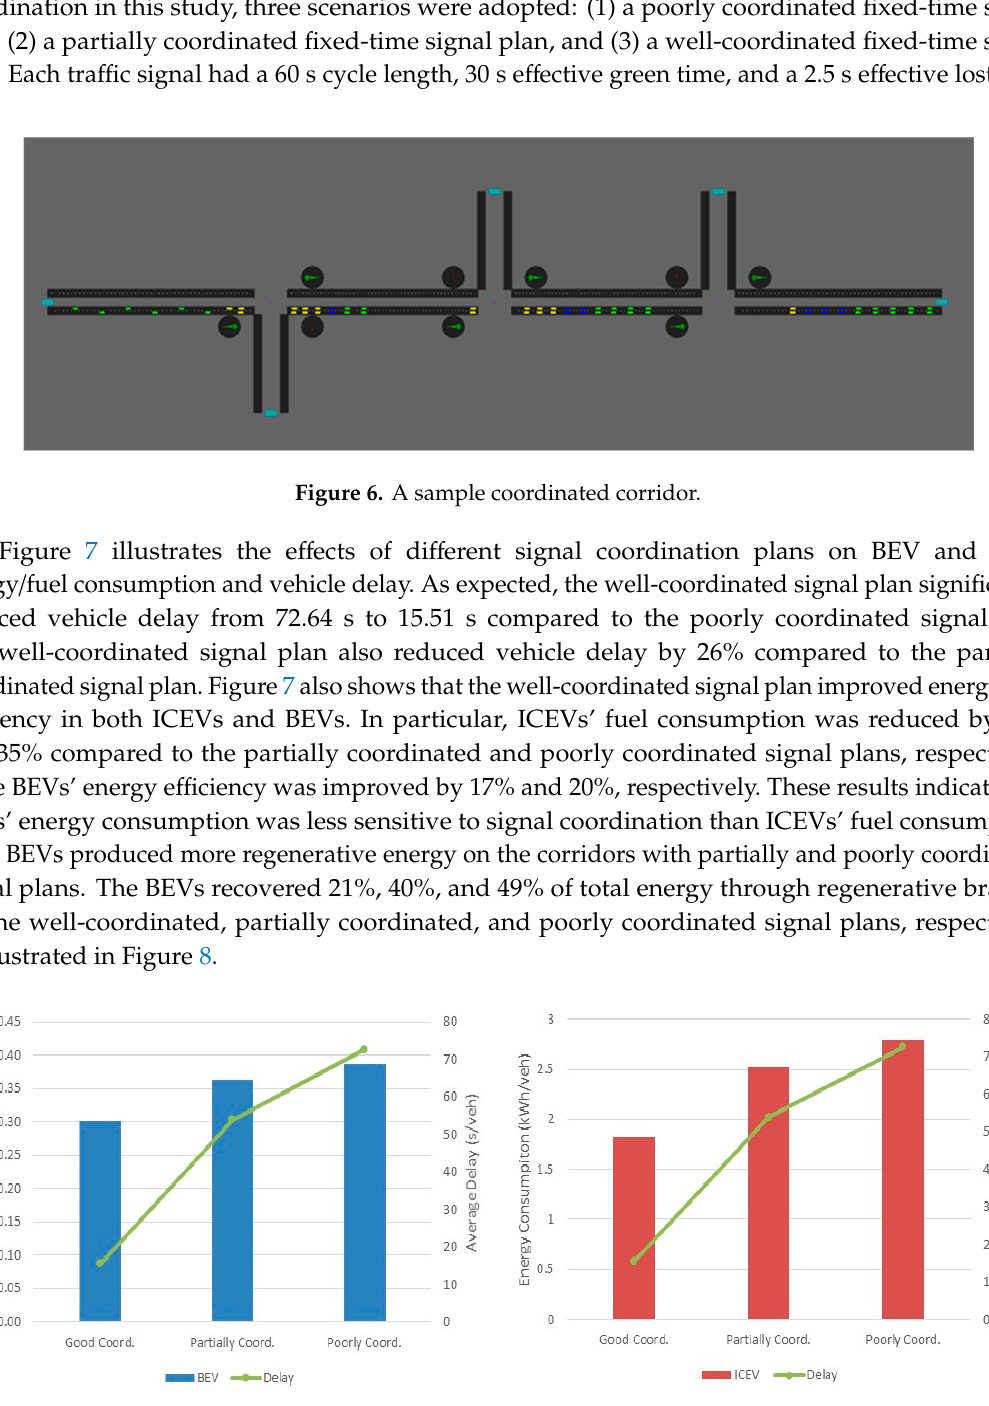
Figure 8. Regenerated energy of BEV for different signal coordination plans. 4. Conclusions and Recommendations for Future Research This study investigated the effects of different intersection controls (i.e., a roundabout, traffic signal, and stop sign) and signal coordination plans (i.e., well ‐ coordinated, partially coordinated, and poorly coordinated) on BEV and ICEV energy/fuel consumption. The second ‐ by ‐ second speed profiles of individual vehicles were derived from a traffic simulation model, and the speed profiles were utilized as inputs to estimate ICEV fuel consumption and BEV energy consumption using microscopic fuel consumption and energy models.